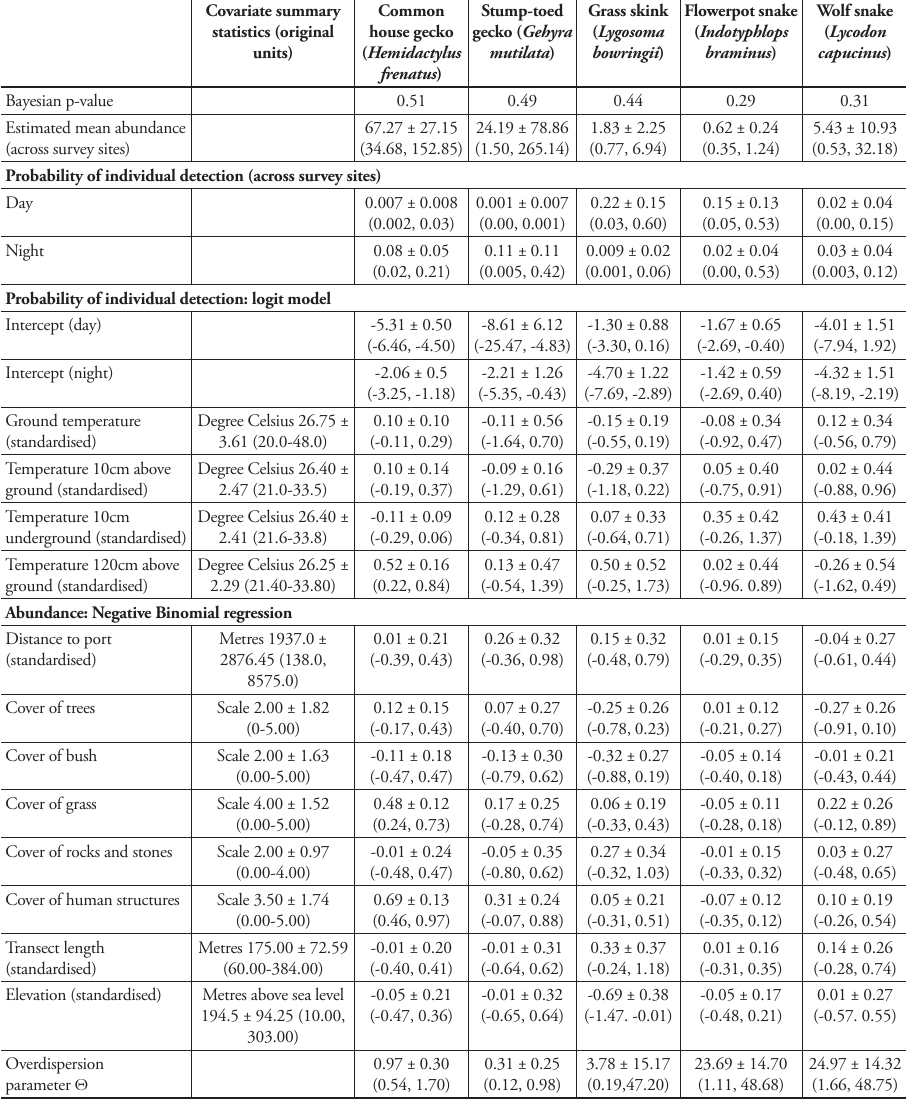
Table 1. Goodness of fit (Bayesian p -values), summary statistics of the covariates (before standardisation; mean ± standard deviation, and range), and posterior coefficient estimates (mean ± standard error, and 95% Credible Intervals) of the abundance-detection models for five species of alien reptiles on Christmas Island.